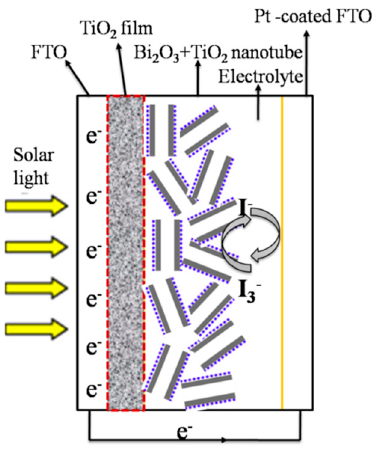
Figure 2. Schematic diagram of the Bi 2 O 3 sensitized TiO 2 nanotubes solar cell.